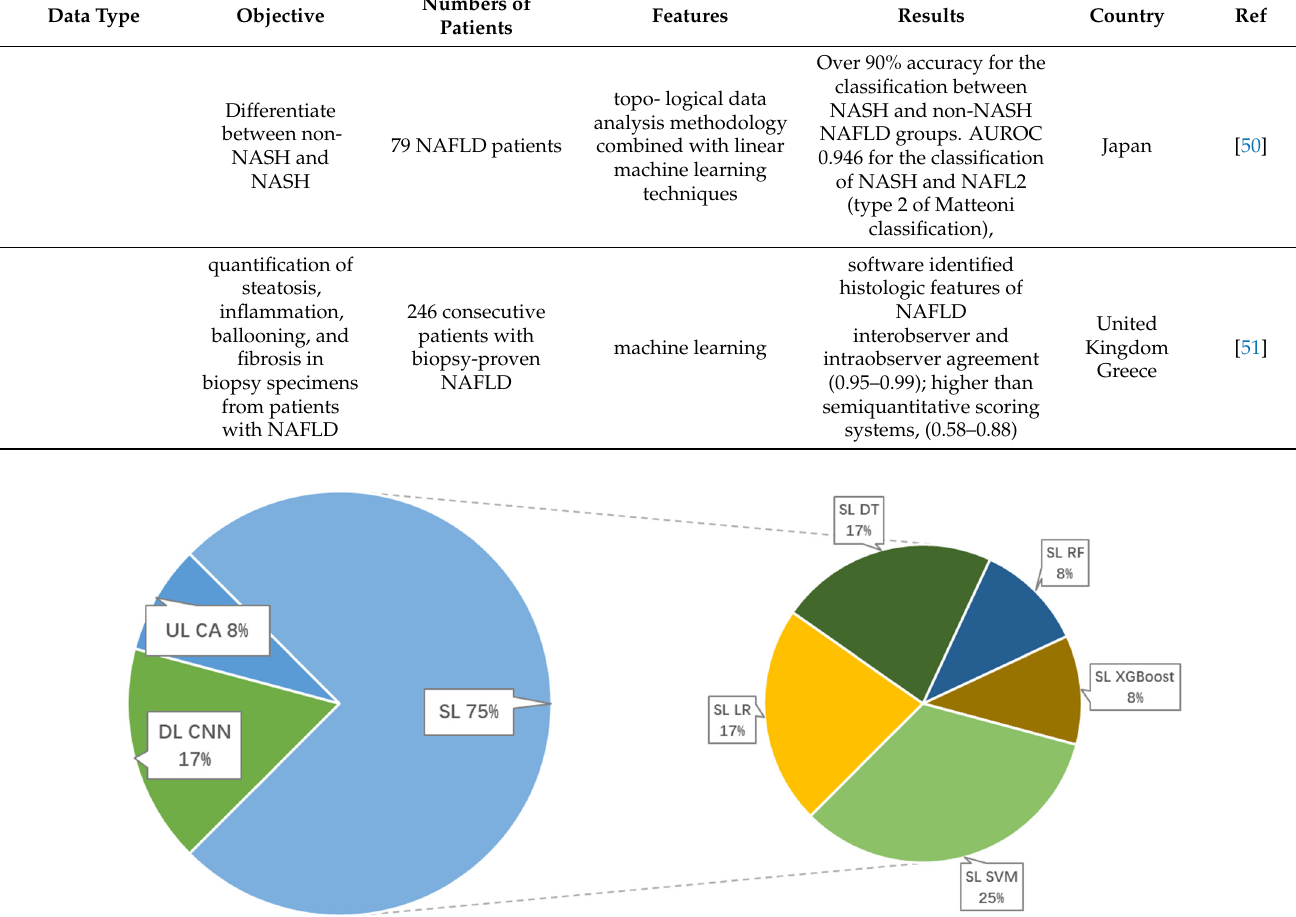
Figure 2. Percentages of applications of various ML techniques for NAFLD. SL: supervised learning; UL: unsupervised learning; DL: deep learning; LR: logistic regression; SVM: support vector machine; DT: decision tree; RF: random forest; CA: cluster analysis; CNN: convolutional neural network.